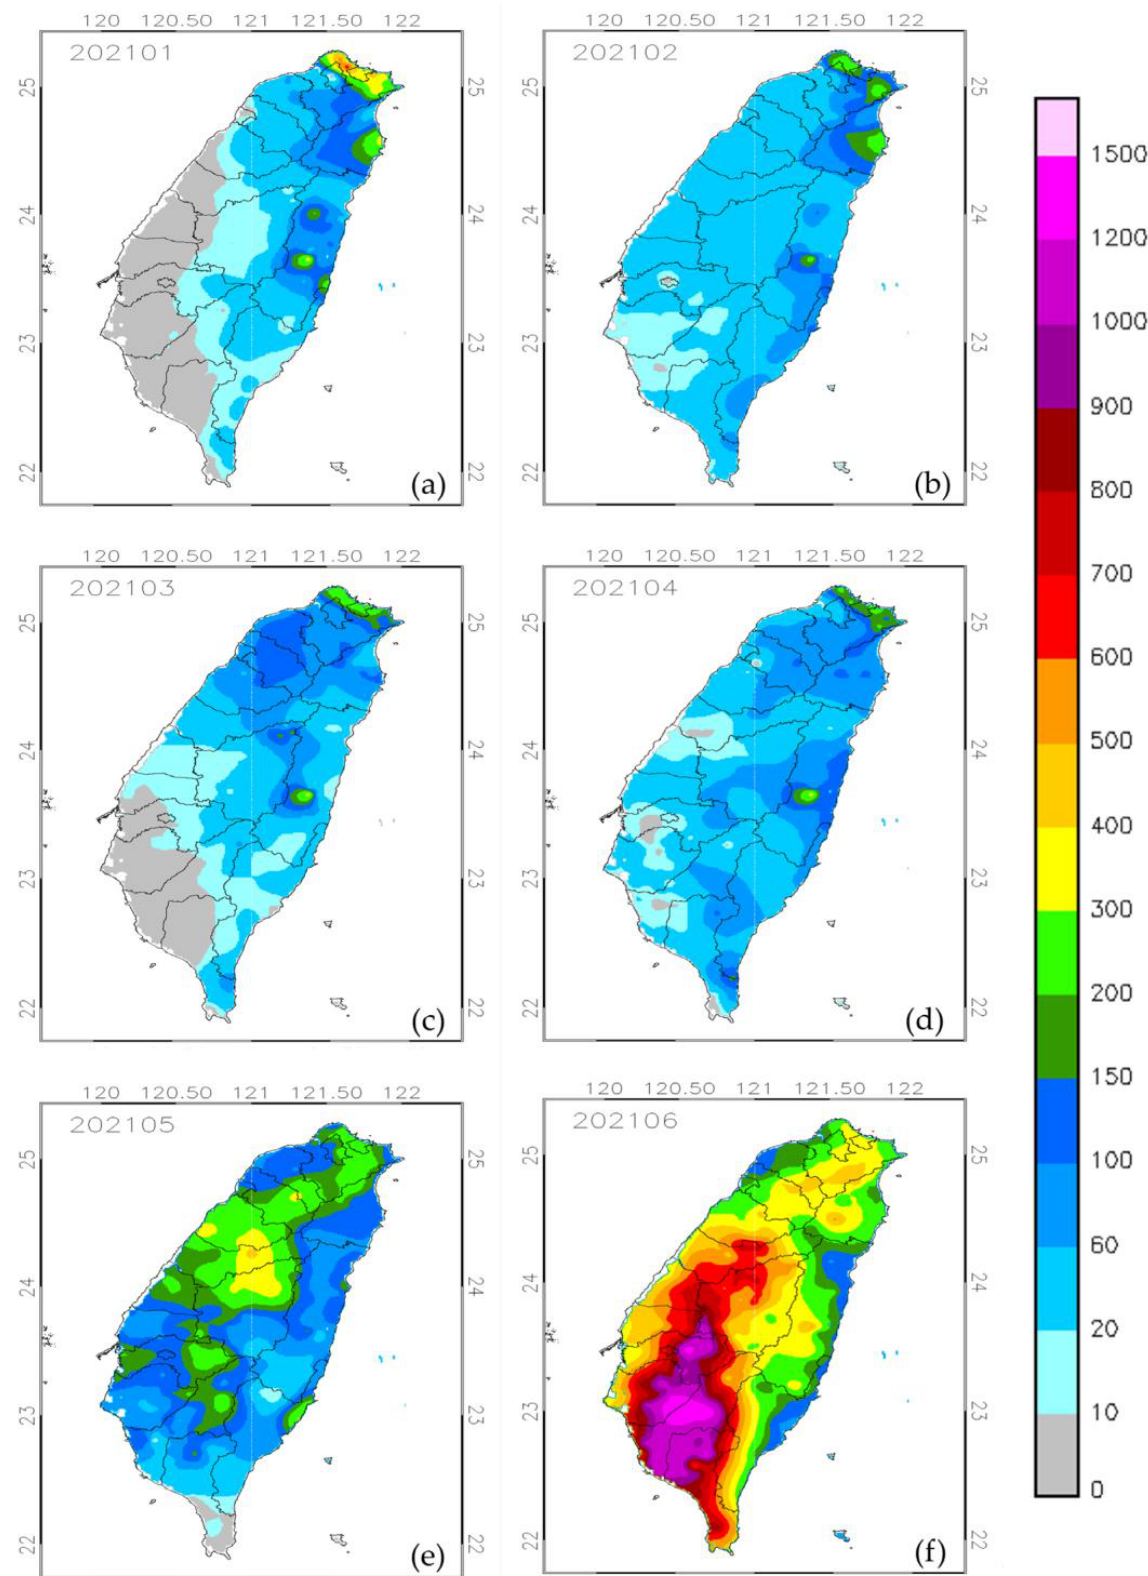
Figure 4. The monthly cumulative precipitation over Taiwan from January to June 2021(from ( a – f )). The color scales are shown on the right.